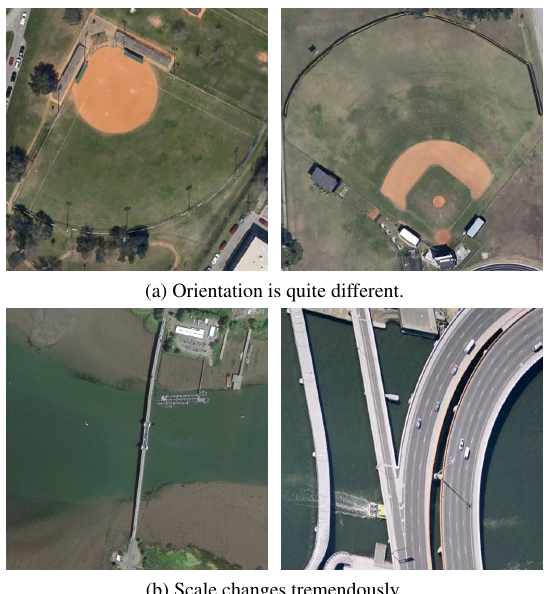
Figure 1. Some challenges in remote sensing scenes. (a) The direction of a baseball field can be downward or upward. (b) A bridge can be as small as several thousand pixels and even as large as millions of